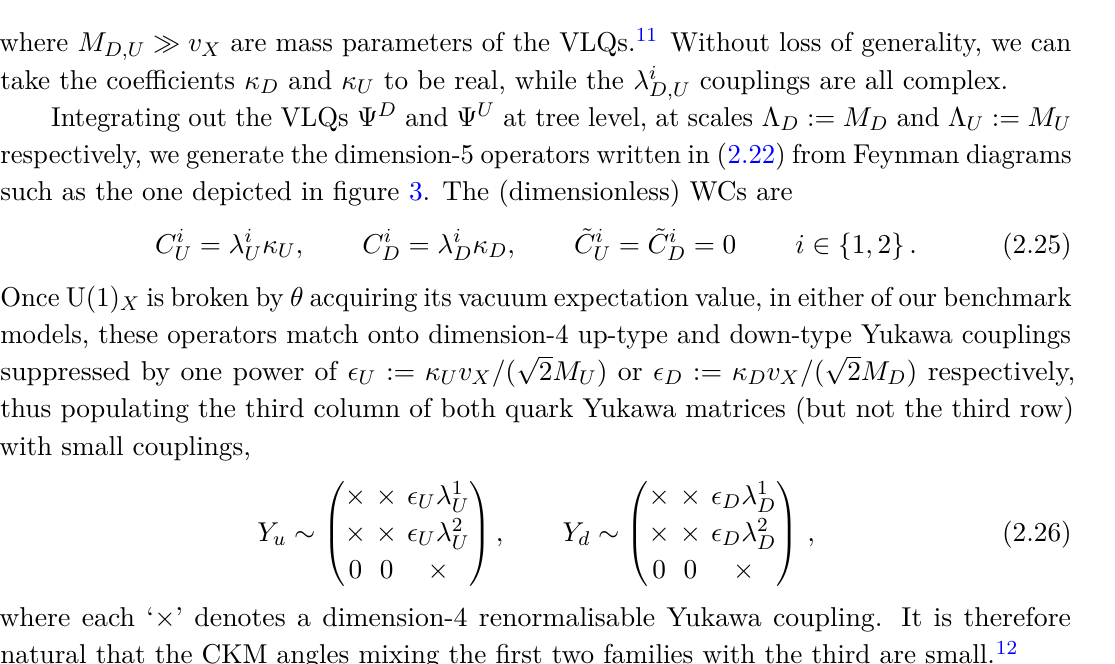
Figure 3 . Feynman diagram that gives the dimension-5 effective up-type Yukawa operators in (2.22), which themselves match onto the 1–3 and 2–3 up-type Yukawa couplings. The corresponding diagrams for down quark Yukawa operators can be obtained by trading every sub/superscript ‘ U ’ for ‘ D ’, and swapping ˜ H for H